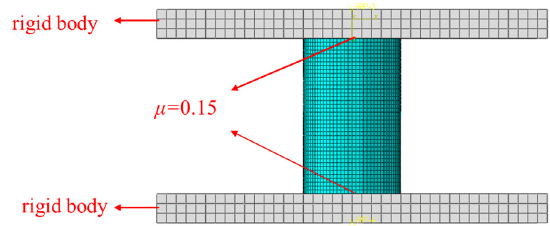
Figure 7. Compressed specimen loading model.